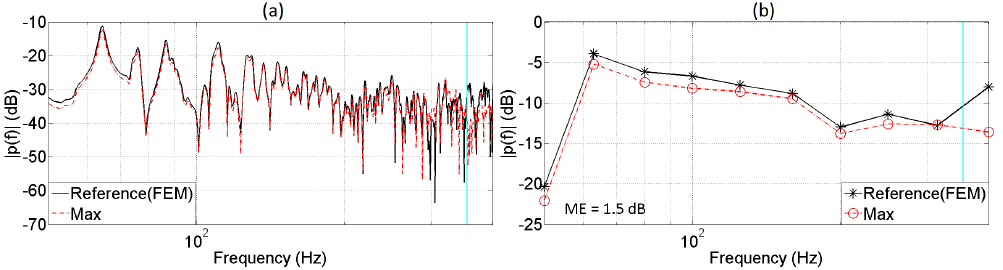
Figure 27. Comparison of full ( a ) and 1/3 octave band ( b ) frequency responses. Translated PWE ( Y ) and reference ( Y ) at translated Position 2.